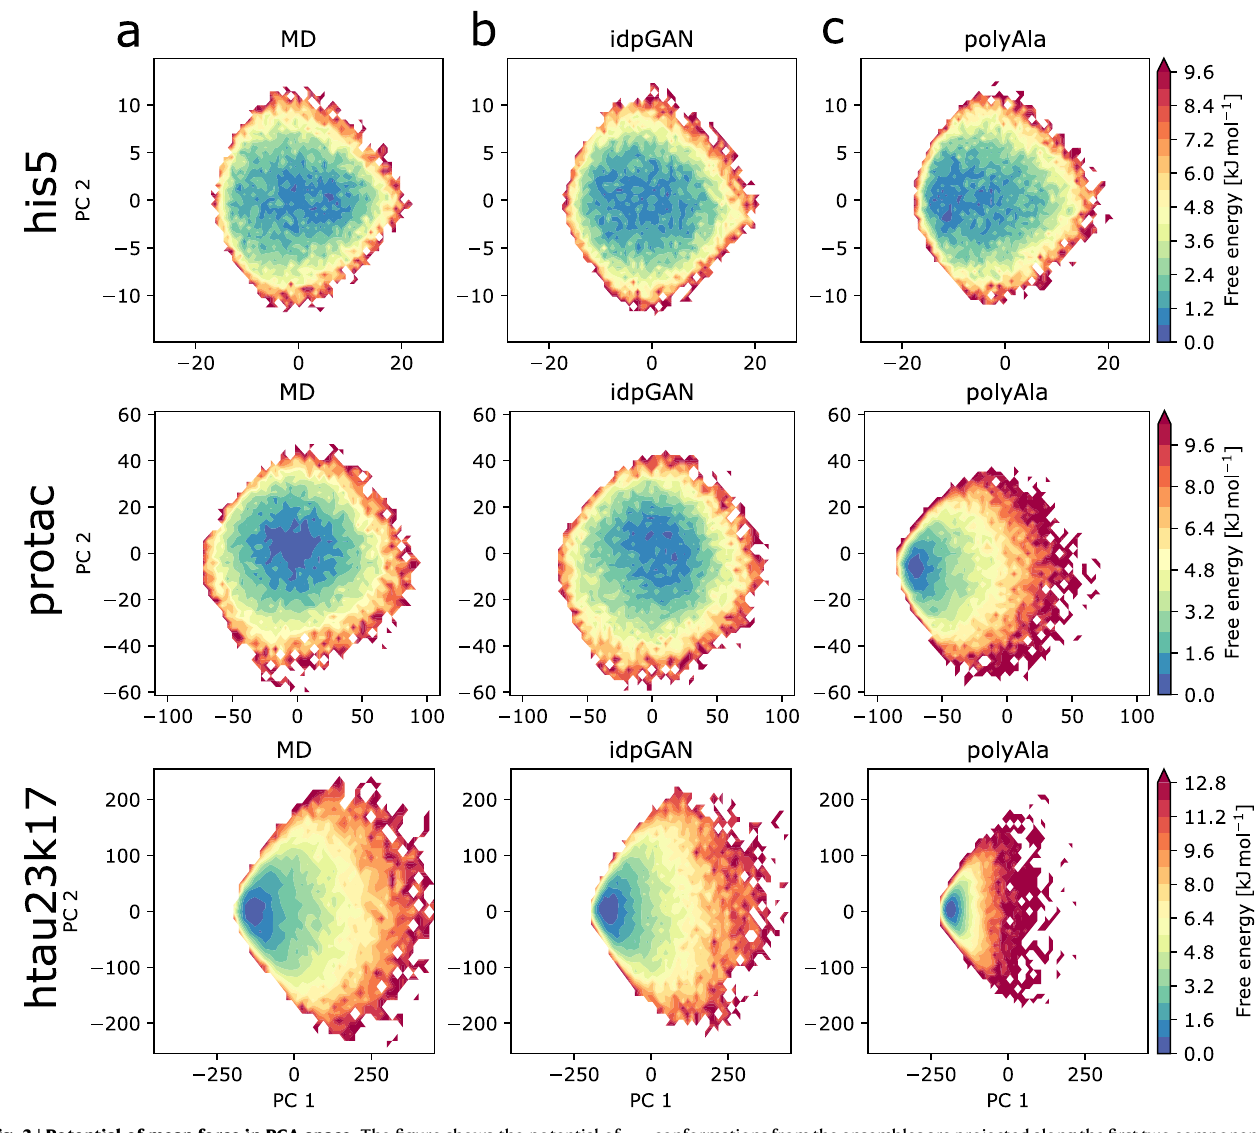
Fig. 3 | Potential of mean force in PCA space. The fi gure shows the potential of meanforcepro fi lesofMD(reference)( a ),idpGAN( b )andpolyAla( c